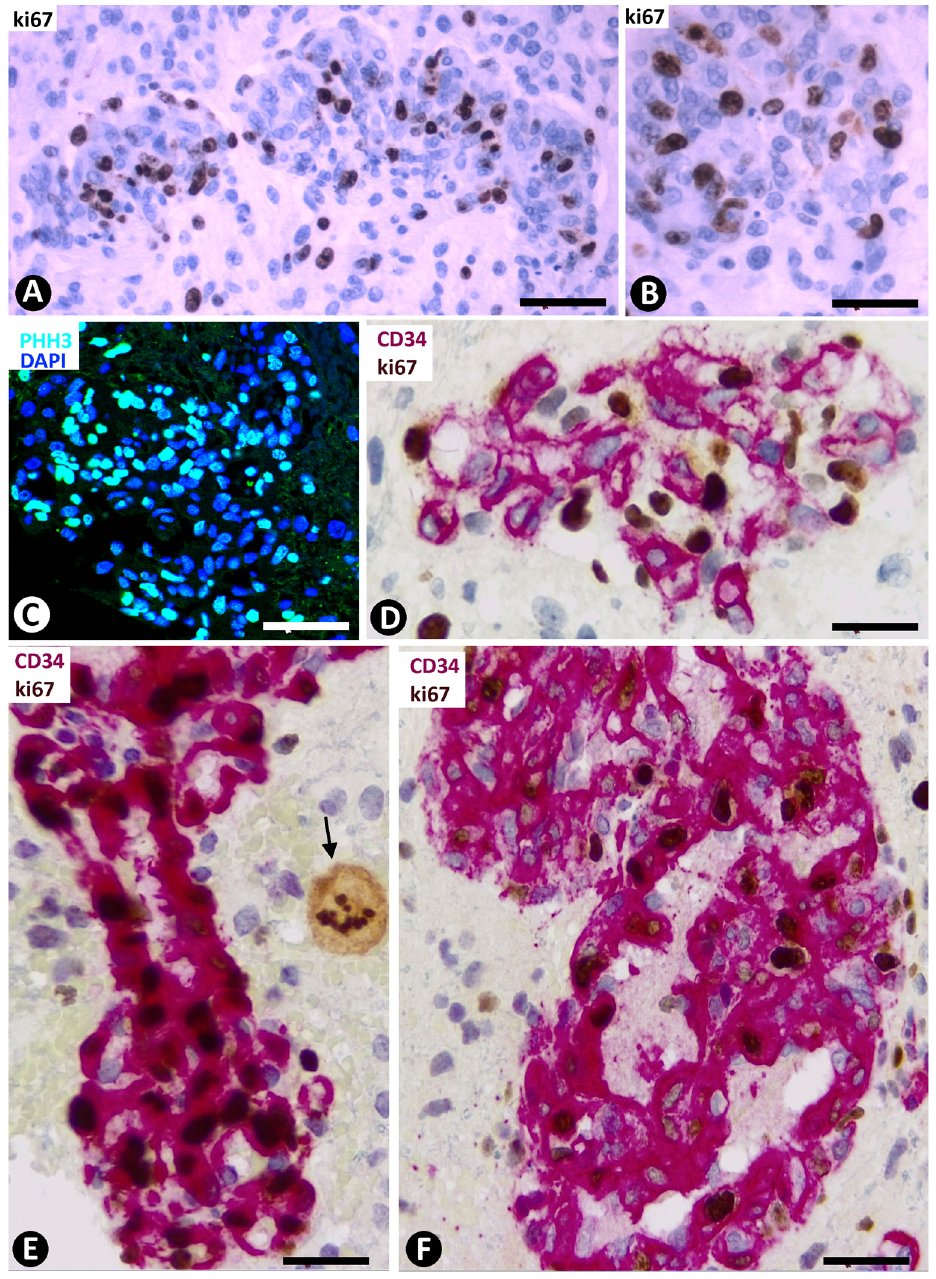
Figure 4. Cell proliferation in bizarre vessels in GBM. ( A – C ) Images showing high numbers of cell nuclei expressing Ki-67 (brown in A , B ) and PHH3 (green in C ) in glomeruloid bodies (high prolif- eration index). ( D ) CD34 ECs (red) do not show Ki-67 expression in their nuclei. Nuclei that express Ki-67 (brown) around ECs are compatible with unmarked pericytes (compare with Figure 4E,F). ( E , F ) Images showing pericytes (red) with high numbers of nuclei expressing Ki-67 (brown). Note in ( E ) a Ki67 + neoplastic cell in mitosis (arrow). ( A , B ) Immunochemistry for Ki-67. Hematoxylin counterstain. ( C ) Immunofluorescence for phospho-histone H3 (PHH3). DAPI counterstain. ( D ) Double immunochemistry for CD34 (red) and Ki-67 (brown). ( E , F ) Double immunochemistry for α SMA (red) and Ki-67 (brown). Hematoxylin counterstain. Bar: ( A , B , D ) 40 µm, ( C ) 45 µm, and ( E , F ) 30 µm.